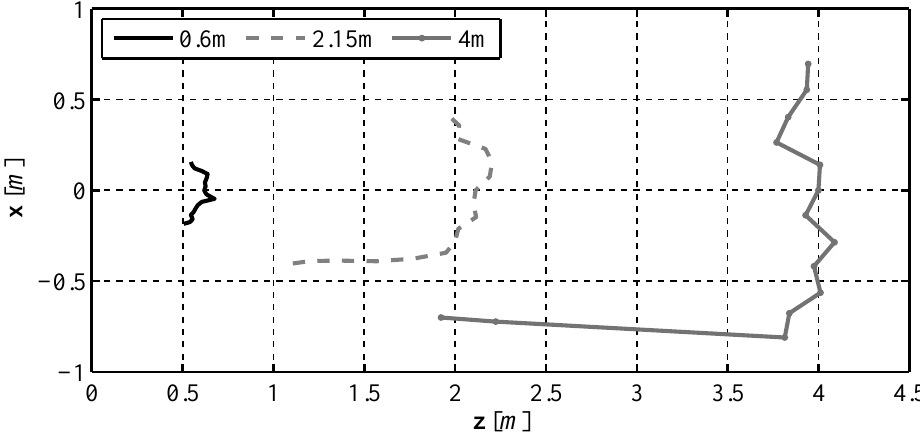
Figure 14. Experimental results when measuring distances